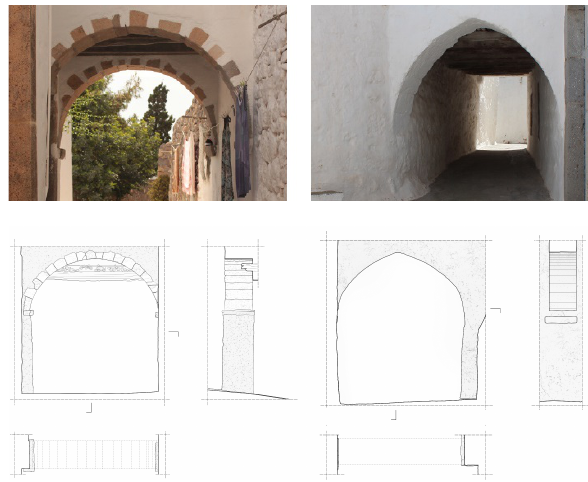
Figure 11. Segmental and pointed arch.